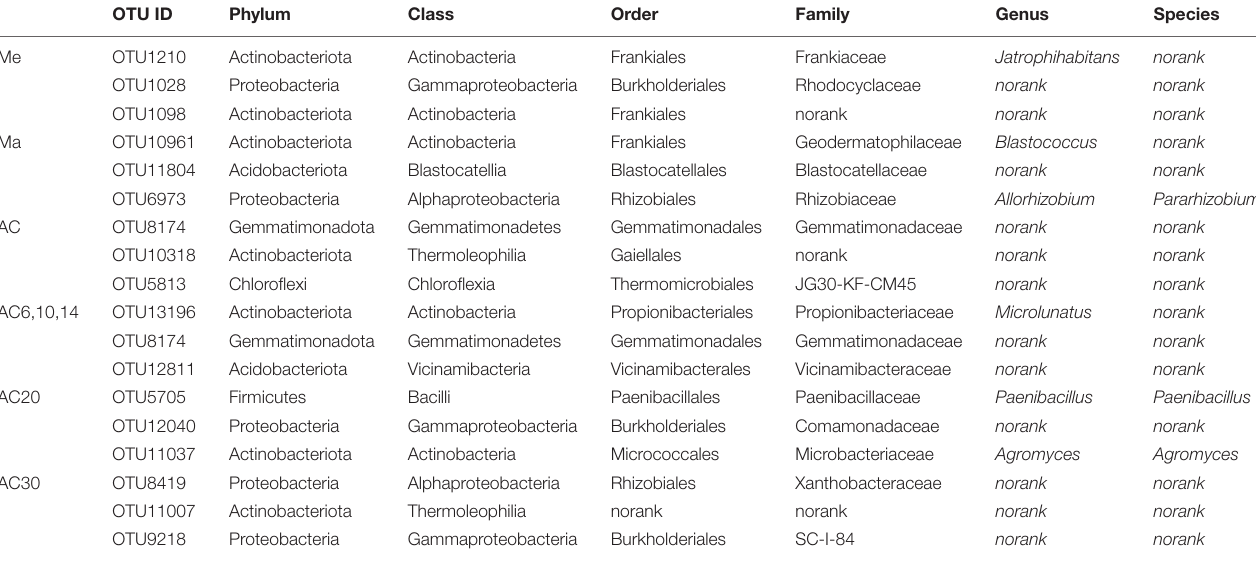
TABLE 4 | Keystone taxa identified in the co-occurrence